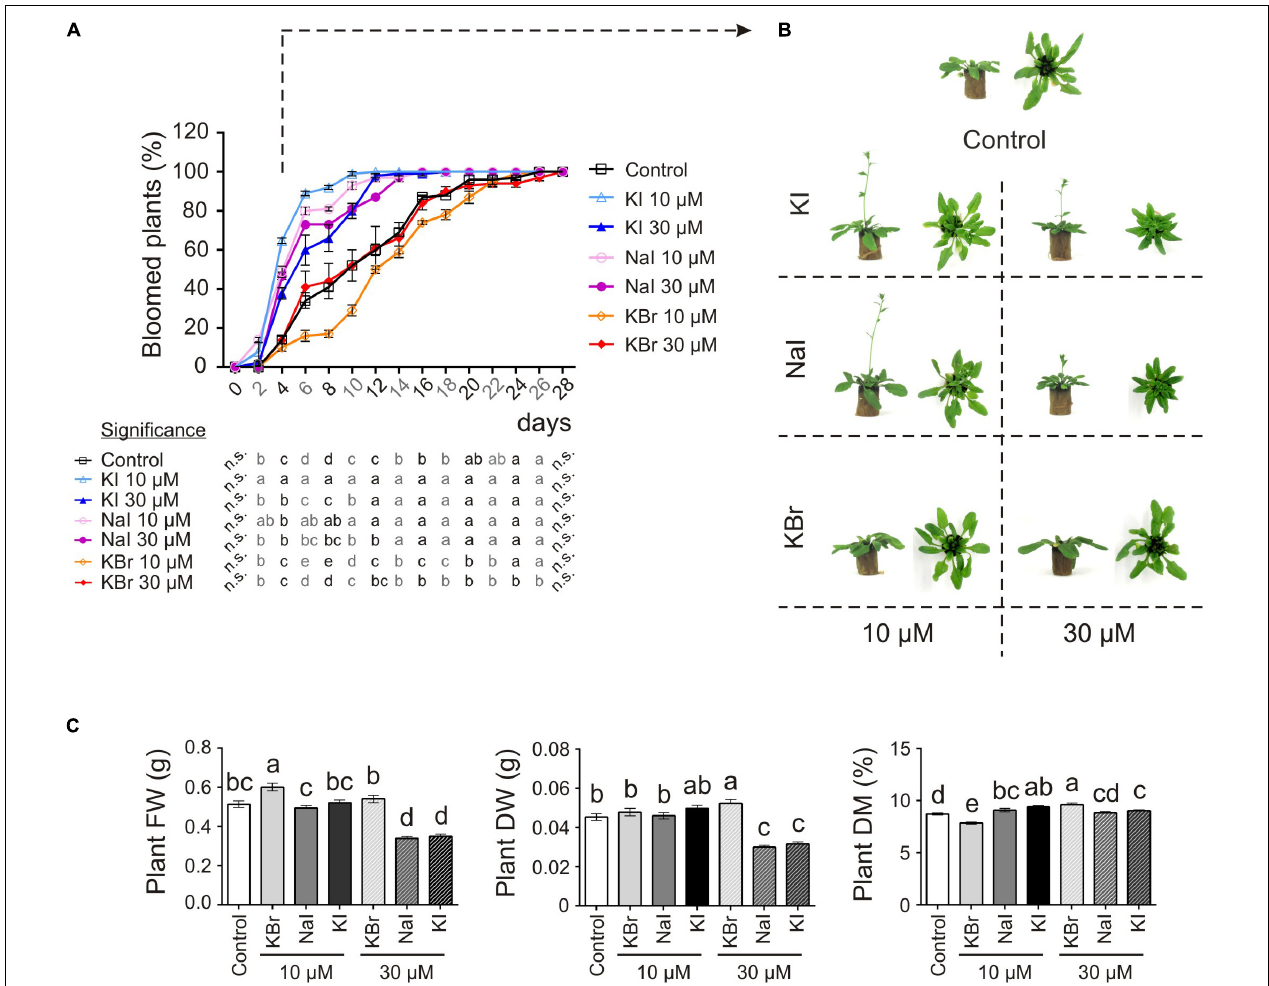
FIGURE 2 | Impact of iodine on plant growth and development (exp. 2-phenotype). (A) Flowering curve; the percentage of bloomed plants/tray was calculated every 2 days after the opening of the first flower (day 0). (B) Representative control, and KI-, NaI- or KBr-treated plants (10 and 30 µ M) after 15 days from the onset of the treatments. Pictures were taken after 4 days from the opening of the first flower on the main stem. (C) Morphological data on plant FW, DW, dry matter content determined 15 days after the onset of the treatments. Values indicated by different letters significantly differ from each other (according with one-way ANOVA, LSD post hoc test, P ≤ 0.05). In particular, the statistical analysis of flowering (A) was performed by comparing the percentage of bloomed plants of each tray (considered as biological replicates) within each sampling point. When data followed a Normal distribution and there was homogeneity of variances, they were subjected to one-way ANOVA and values indicated by different letters significantly differ from each other (LSD post hoc test, P ≤ 0.05). When one of this two prerequisite was violated, a Kruskal-Wallis test was performed. Error bars ( ± SE) are shown in